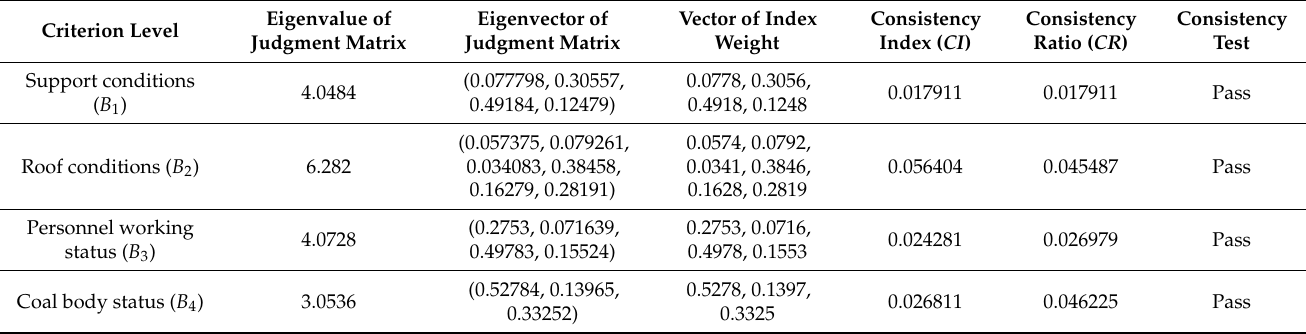
Table 5. Related calculation results of the judgment